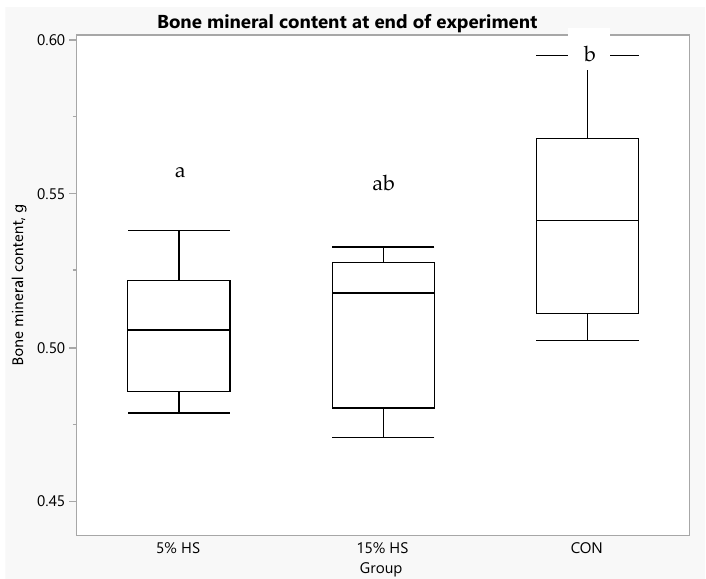
Figure 11. Box plot of bone mineral content (g) at the end of the experiment. Measurements obtained by dual-energy X-ray absorptiometry in live mice. N = 8 per group. Boxes depict: 75th percentile (upper edge), 50th percentile/median (middle line), 25th percentile (lower edge) and whiskers (maximum and minimum values). ANOVA main effect of group, p = 0.022. Boxes not sharing letter superscripts are significantly different.